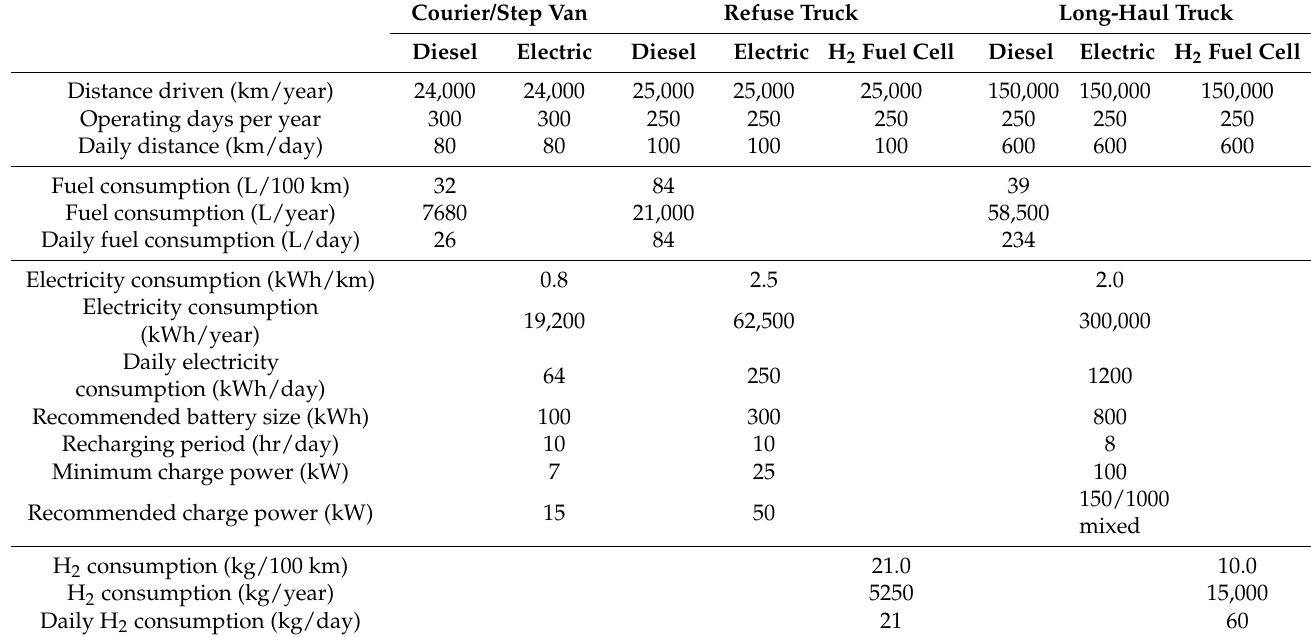
Table 6. Annual results (if not specified differently) for diesel, battery electric and hydrogen fuel cell trucks (per vehicle). Courier/Step